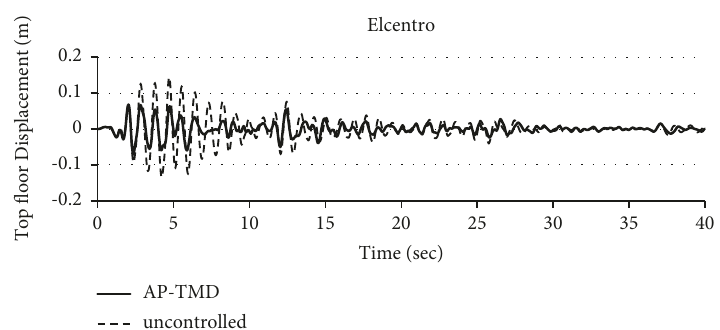
Figure 15: Top floor displacement of structure under Elcentro.